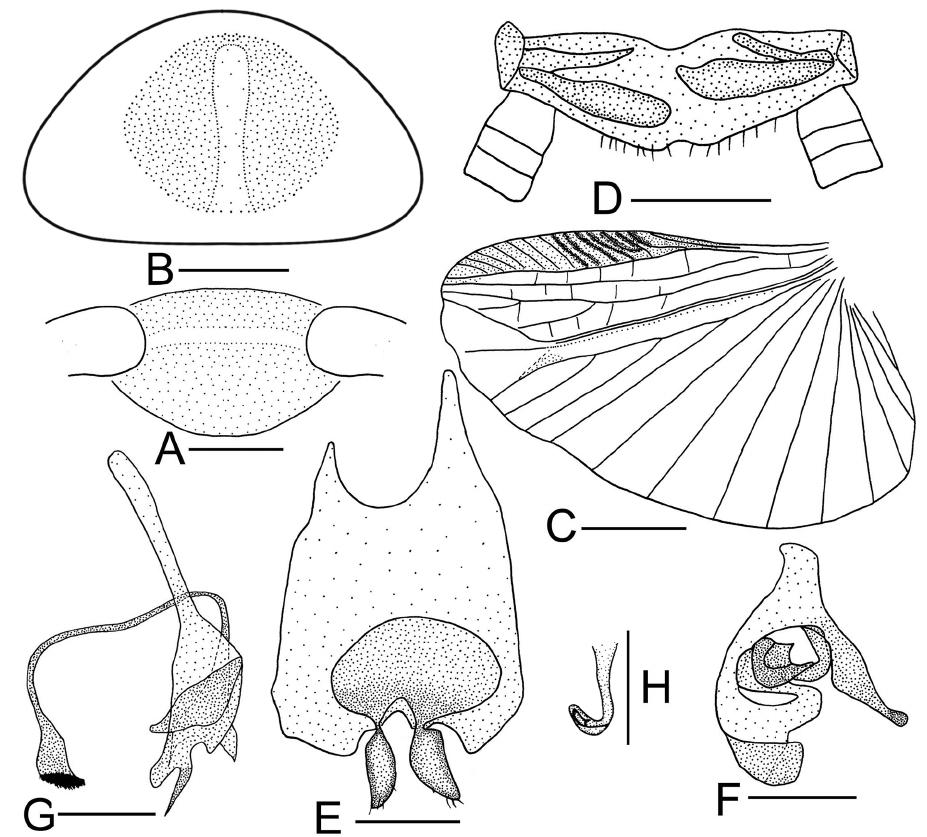
Figure 9. Sorineuchora hispida sp. n. holotype. A vertex B pronotum C hind wing (the dotted line indicates wing fold) D supra-anal plate, ventral view E subgenital plate, dorsal view F phallomere L1 G phallomere L2vm and R3 H phallomere R2. Scale bars: 0.5 mm ( A, D–H ), 1.0 mm ( B ), 2.0 mm ( C ). Description. Measurements (mm). Holotype, male, body length without cerci: 7.0; overall length including tegmen: 8.6; pronotum length × width: 1.7 × 2.7; tegmen length: 7.5. Paratypes, body length without cerci: male 6.4–7.6, female 6.5; overall length including tegmen: male 8.8–9.2, female 9.1; pronotum length × width, male 2.05 × 2.75, female 1.7 × 2.8; tegmen length, male 7.5–7.6, female 7.8. Male. Body small, brown. Lower half vertex yellowish brown, with one white transverse stripe (Fig. 9A). Antennae with first three basal antennomeres light yel- (Figs 9B, 12G), lateral margins hyaline. Hind-wing radial field brown. Legs brownish yellow. Abdomen black brown, the hind margins